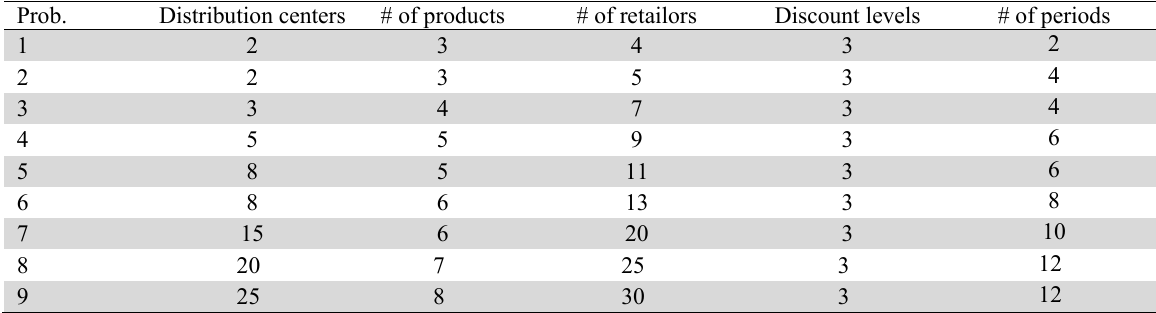
The summary of test data Prob.